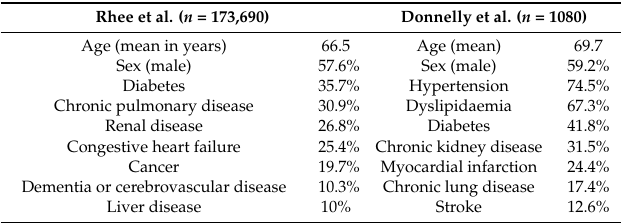
Table 1. Mean age, sex and major co-morbidities associated to sepsis.